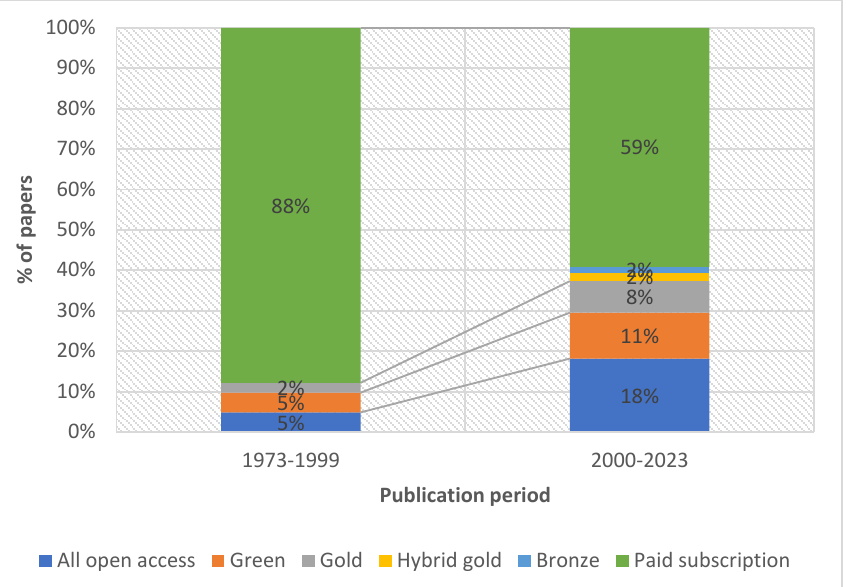
Figure 5. Paper’s access type in the period 1973−1999 vs. 2000−2023; Source: Authors’ work based on Scopus.